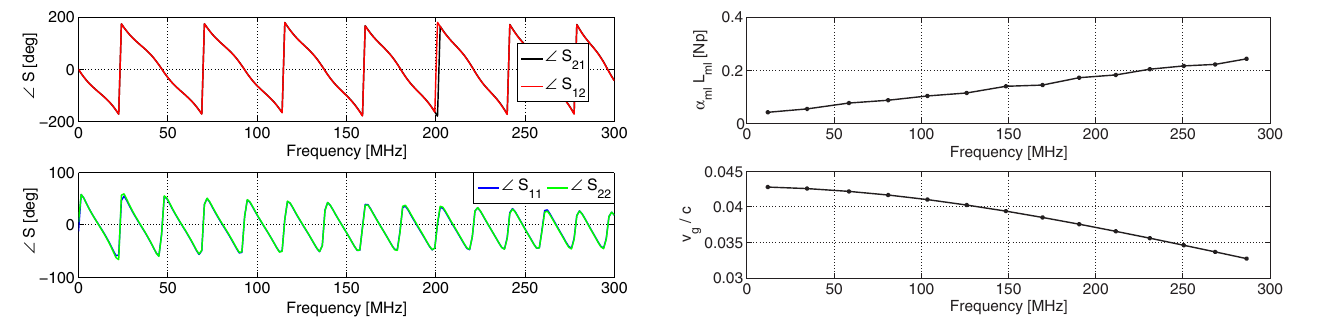
FIG. 8. Phases of the S ml parameters.